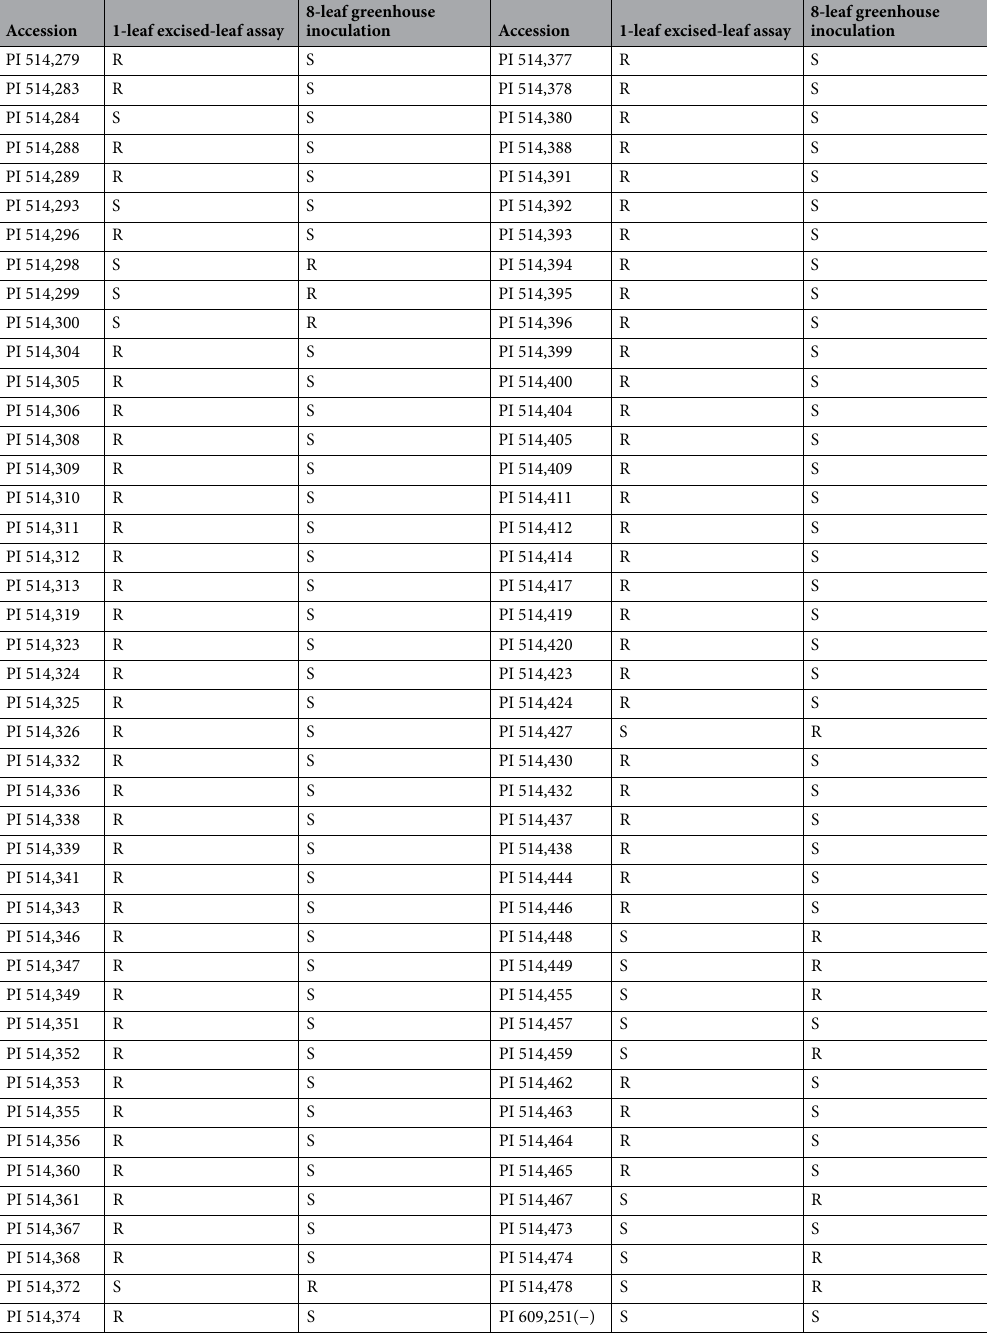
Table 1. Reaction of the Senegalese accessions inoculated with a C. sublineola isolate from Texas (FSP53) at 1-leaf stage through excised-leaf assay compared with reaction of the identical accessions at the 8-leaf stage inoculated through greenhouse spray inoculation with a mixture of Texas isolates of C. sublineola in 2019 8 . In sum, 84 accessions showed different results in the two studies. Accessions not listed in Table 1 were resistant in both studies 8